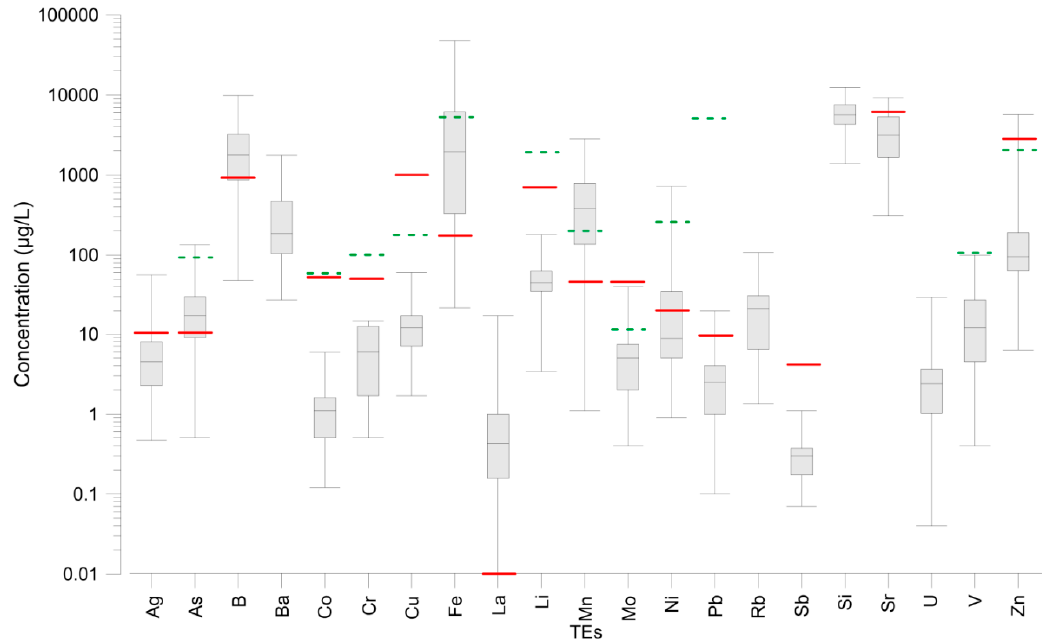
Figure 7. Box plots of TEs concentrations of all water samples (n = 104); red lines represent the limits posed by Italian Environmental Legislation 152/06 [73] and, when not present, other international sources as indicated in Table 1. Green dotted lines stand for recommended maximum values for irrigation water as reported by FAO [87]. Refer to Table 1 for numerical values.